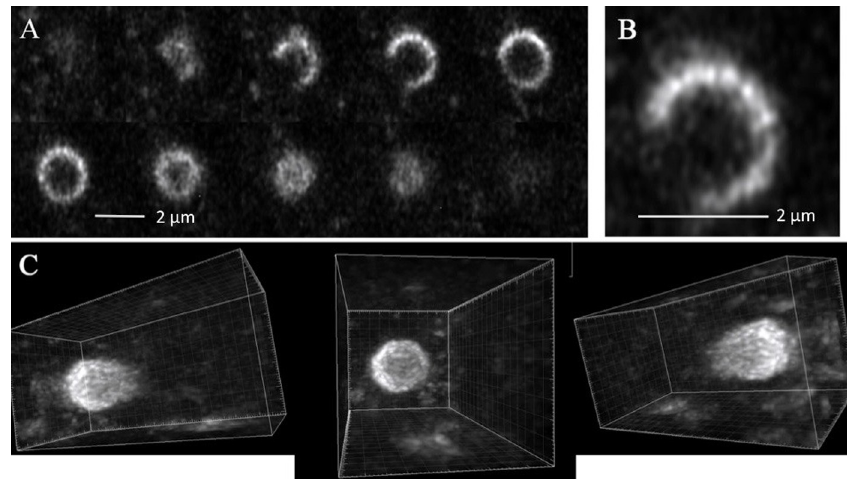
Fig 2. Three-dimensional structure of the PVC. The images are optical sections of a hyphal tip expressing RAB- 7-RFP. 40 images were obtained over a depth of 10 microns. In panel A 10 optical sections are shown, each separated from the other by approximately 0.39 microns. Panel B shows an enlargement of the 4th optical section from panel A. Panel C shows the images as reconstructed in three dimensions, viewed from three different angles of rotation.